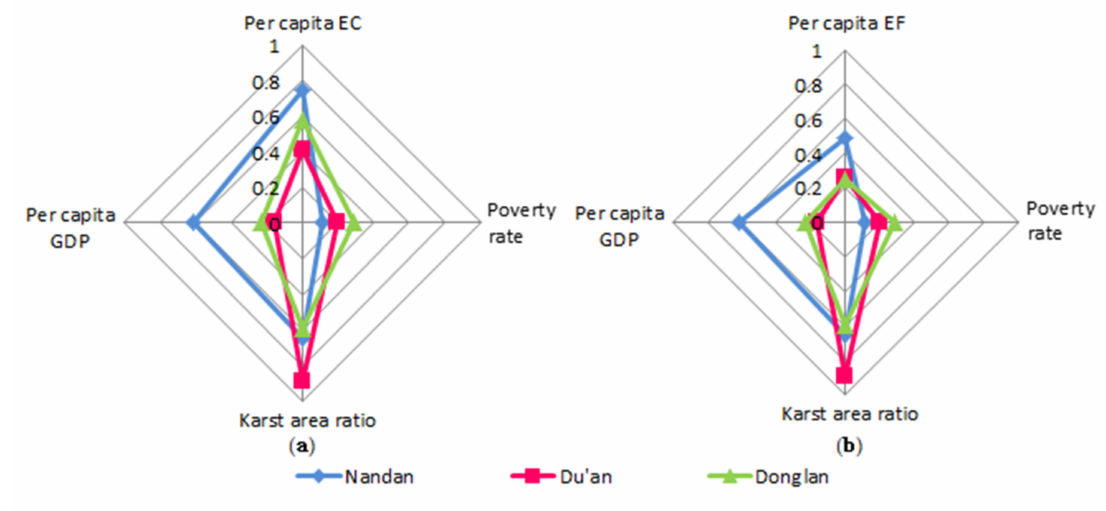
Figure 9. ( a ) Comparison of karst area ratio, poverty rate, per capita GDP, and per capita EC in Nandan County, Du’an County, and Donglan County; ( b ) comparison of karst area ratio, poverty rate, per capita GDP, and per capita EF in Nandan County, Du’an County, and Donglan